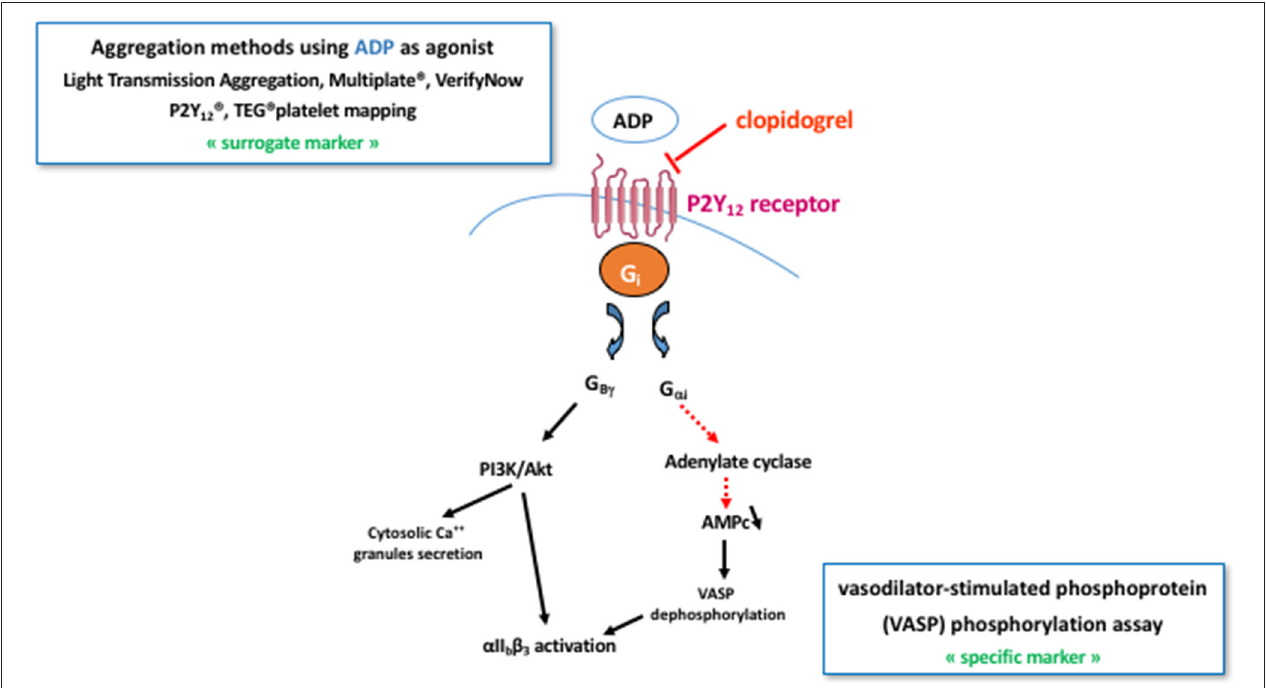
FIGURE 5 | Pharmacodynamics of clopidogrel. Clopidogrel pharmacodynamics can be evaluated using either an aggregation-based method with ADP as platelet agonist or, more specifically by measuring the phosphorylation rate of the vasodilator-stimulated phosphoprotein (VASP) using flow cytometry or ELISA assays. The former can use the gold standard method for platelet function analysis, i.e. light transmission aggregometry, or one of the commercialized point-of-care tests, mainly Multiplate ® , VerifyNow P2Y 12 , and TEG ® platelet mapping. PI3K, phosphoinositide